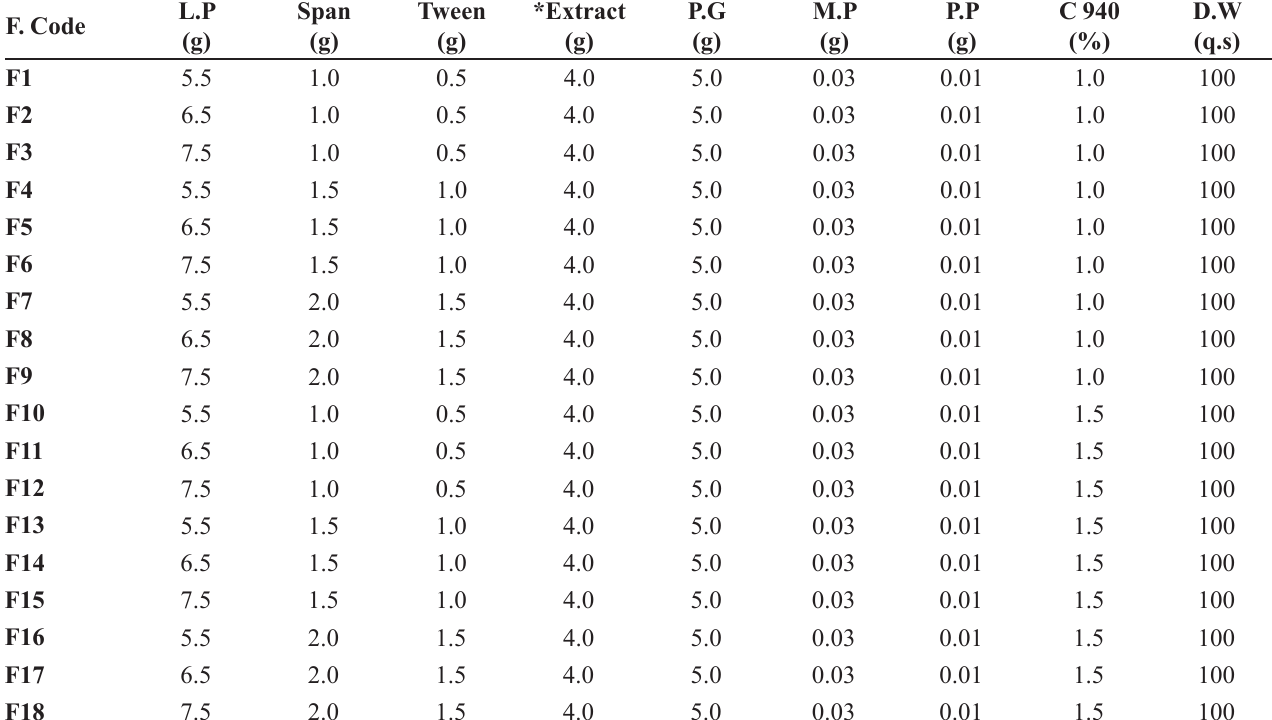
TABLE I - Composition of test formulations of CT emulgel F.